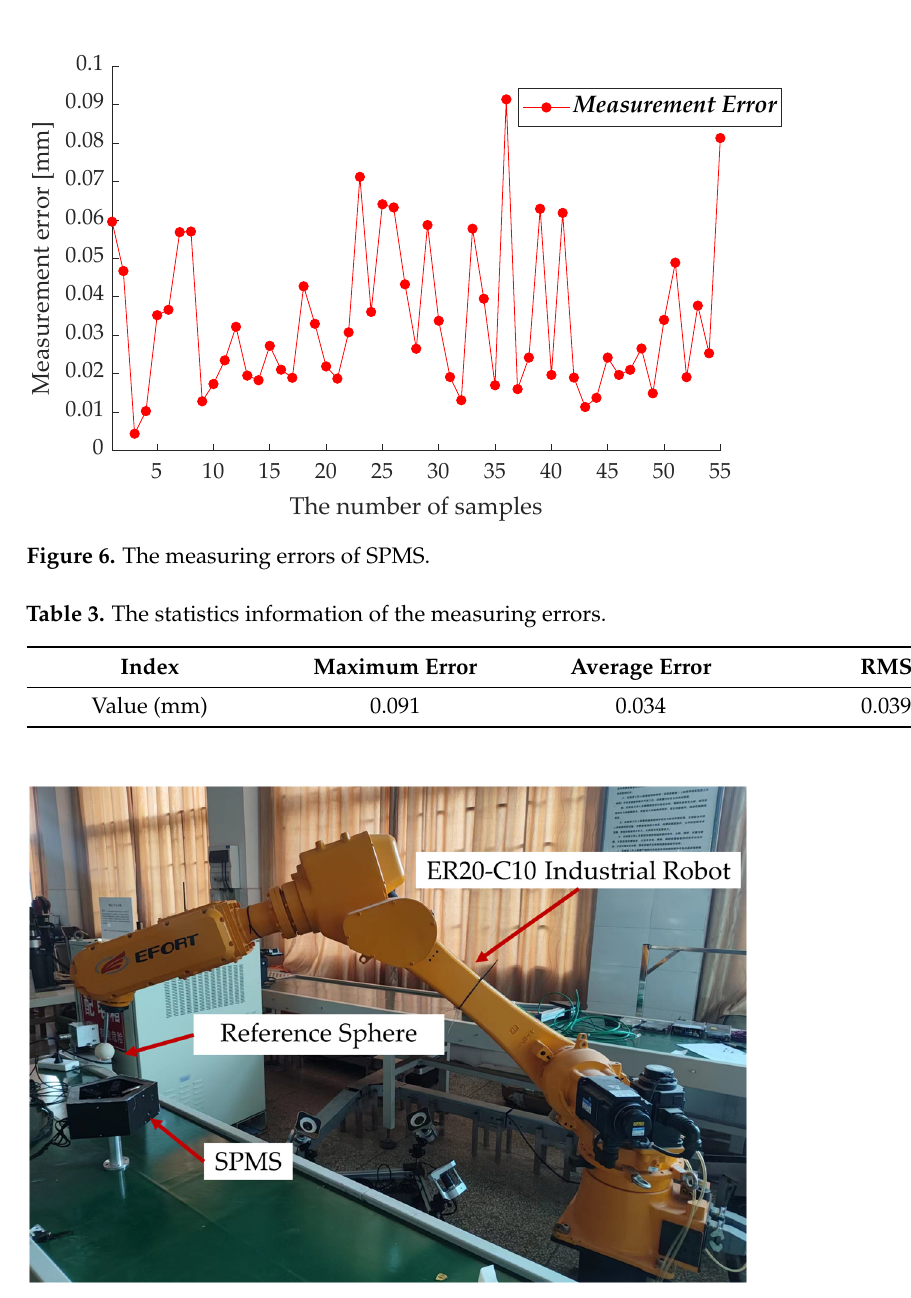
Figure 7. The experiment platform for kinematic calibration of robots. The nominal kinematic parameters of the ER20-C10 robot before calibration are shown in Table 4. Table 4. The kinematic parameters of the ER20-C10 robot before calibration.